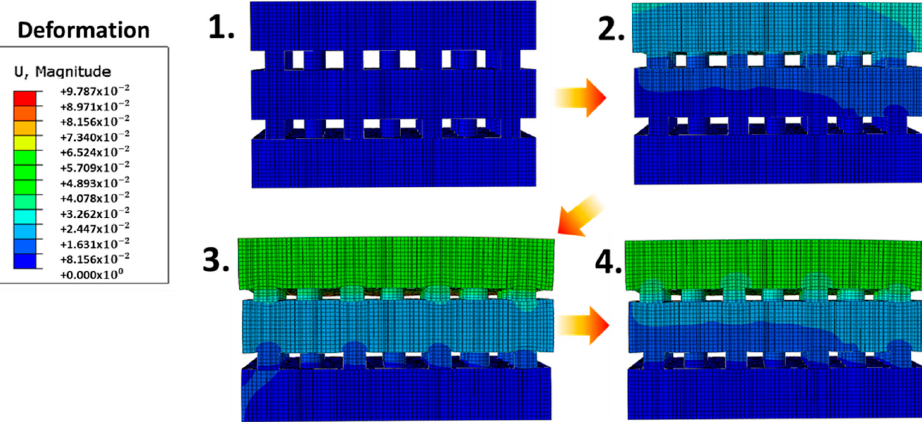
Figure 3. Finite-element calculations (deformation 0–9.787 cm) of the deformed multilayer composite with modulus gradient under